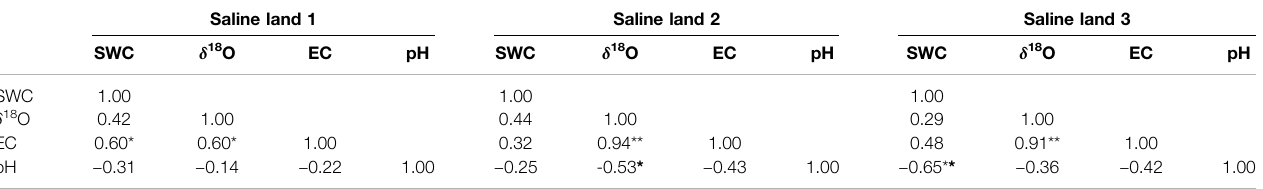
TABLE 4 | Relationship among soil water content (SWC), soil water oxygen composition, soil electrical conductivity (EC) and pH (0 – 100